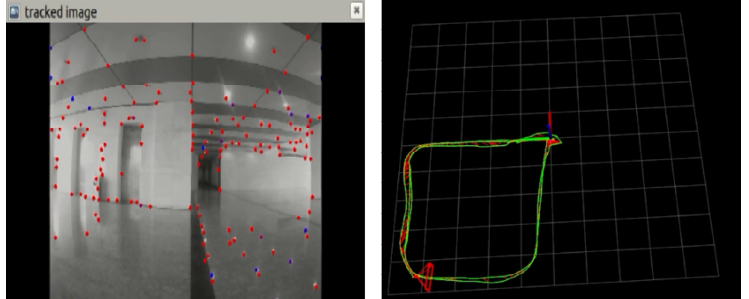
Figure 14. Localization results of algorithm in the paper in a low-texture environment.